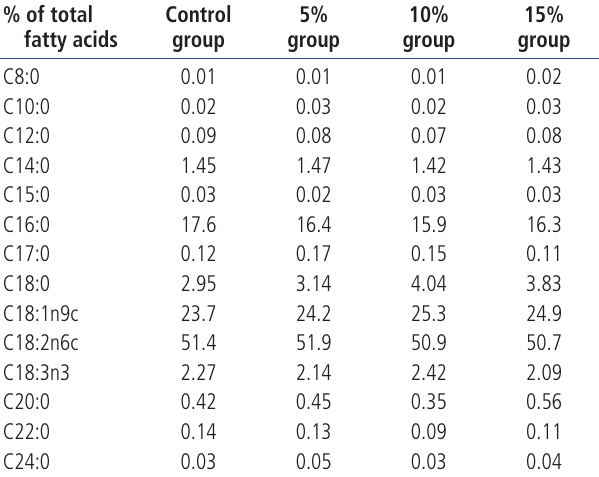
Table 2. Fatty acids composition of the